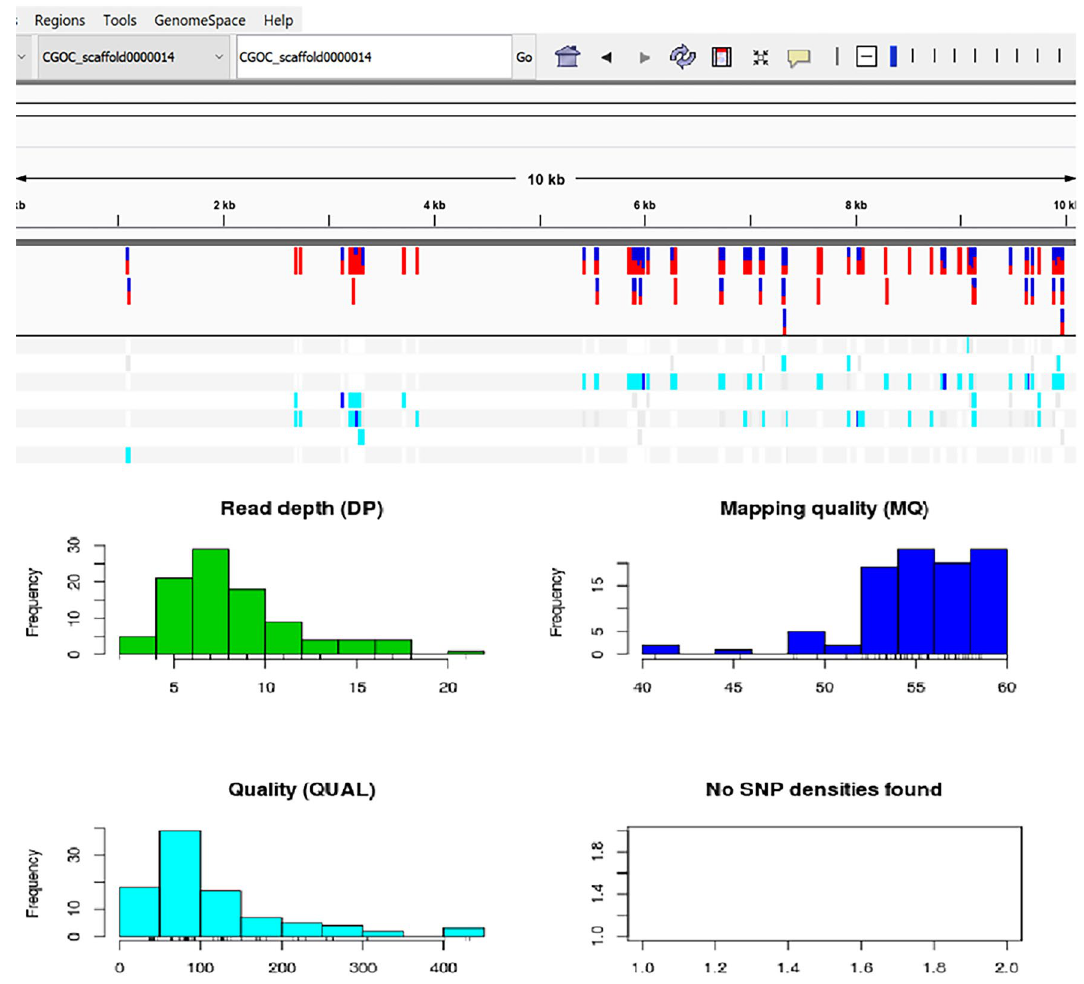
Figure 4. IGV snap shot of C. goldi VCF file: IGV view and statistics of. vcf file for reads mapped to C. goldi scaffold (CGOC_000014) . Edited by Microsoft paint, version 21 H2, https:// www. micro soft. com/ en- us/ windo